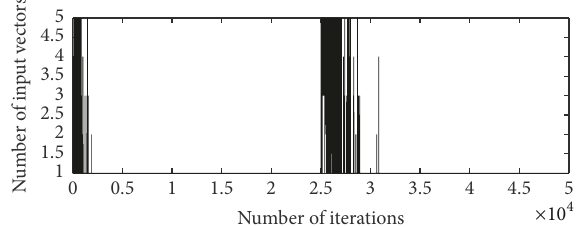
Figure 9: Zoomed view of the number of input vectors used in the proposed FXECAP-L algorithm when 𝐿 = 5 and 𝑏 = 2 in a variant single-channel system.